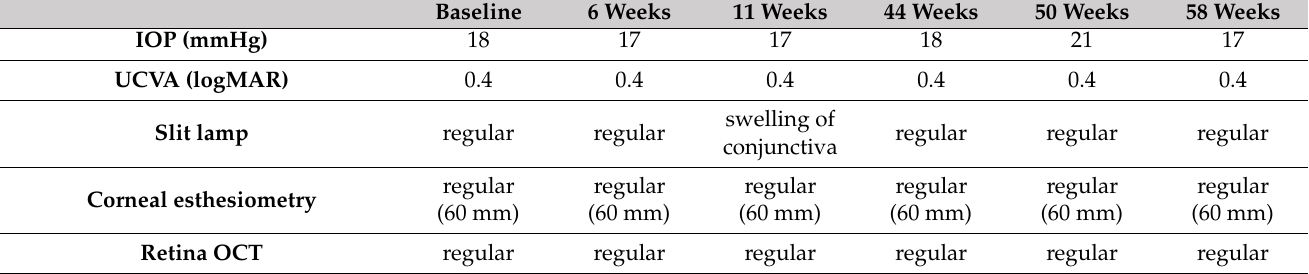
Table 1. Summary of ophthalmological examinations at baseline, and at 6, 11, 44, 50, and 58 weeks after baseline monitoring. The conducted examinations included measurement of the intraocular pressure (IOP), visual acuity, slit lamp examination of the cornea, corneal esthesiometry (Cochet– Bonnet), and retinal optical coherence